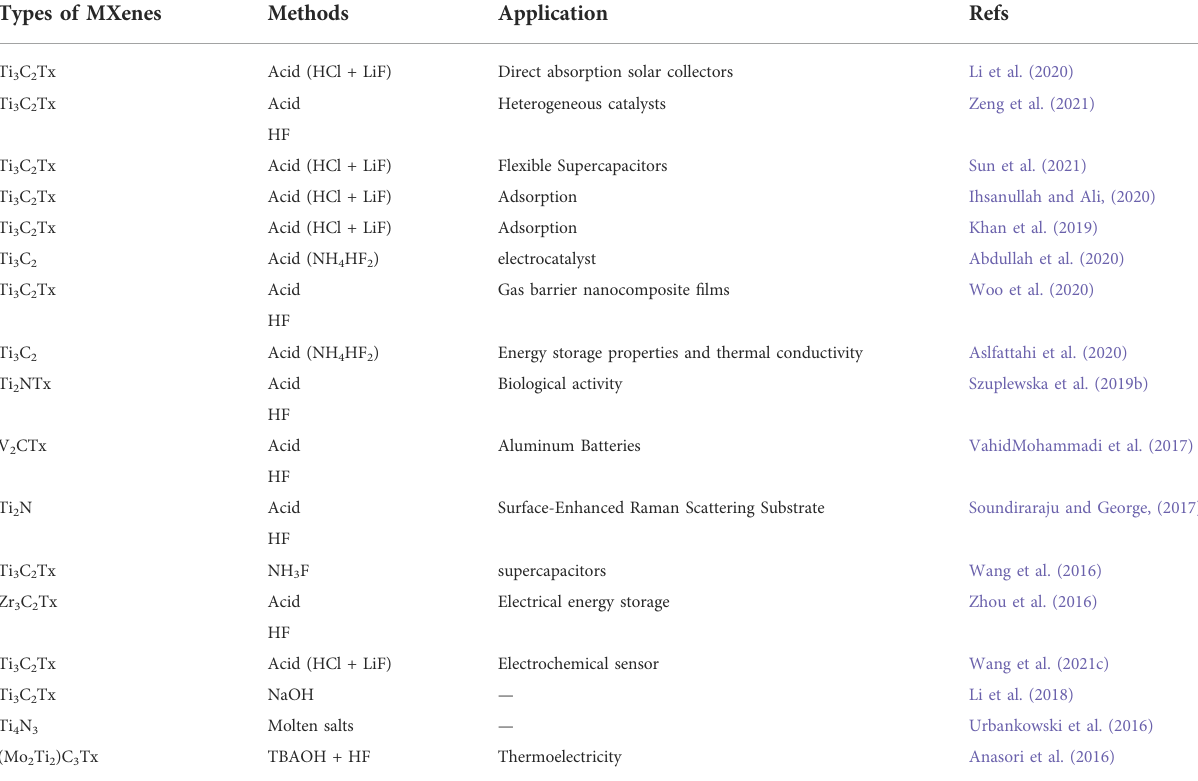
TABLE 1 Various types of MXenes synthesis